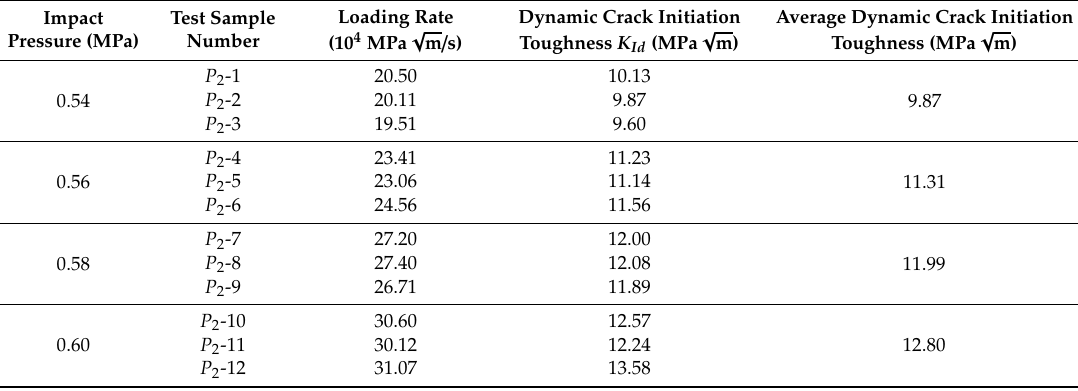
Table 4. Dynamic crack initiation toughness of shale loading with